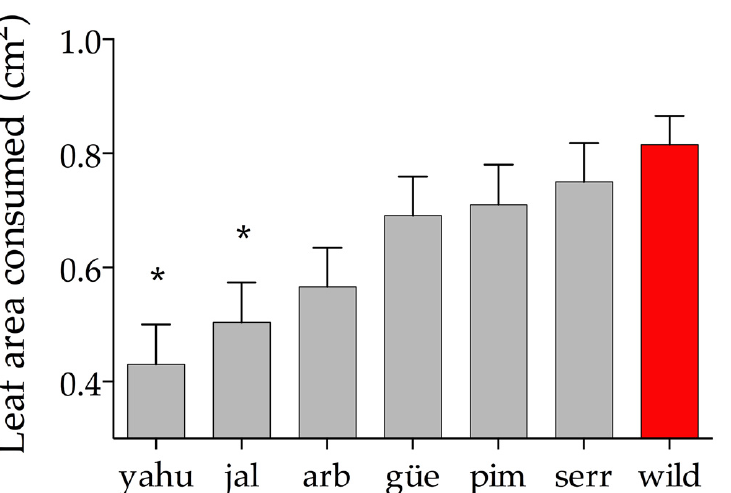
Figure 5. Univariate ANOVA was used to compare the leaf consumption rate of Spodoptera frugiperda of wild populations and cultivated varieties. Red bars indicate the mean and 1 ± SE for the wild variety. Gray bars indicate the mean and SE of the cultivated varieties. The asterisks indicate which cultivated variety significantly differs from the wild variety after Tukey’s HSD test ( α = 0.05) .